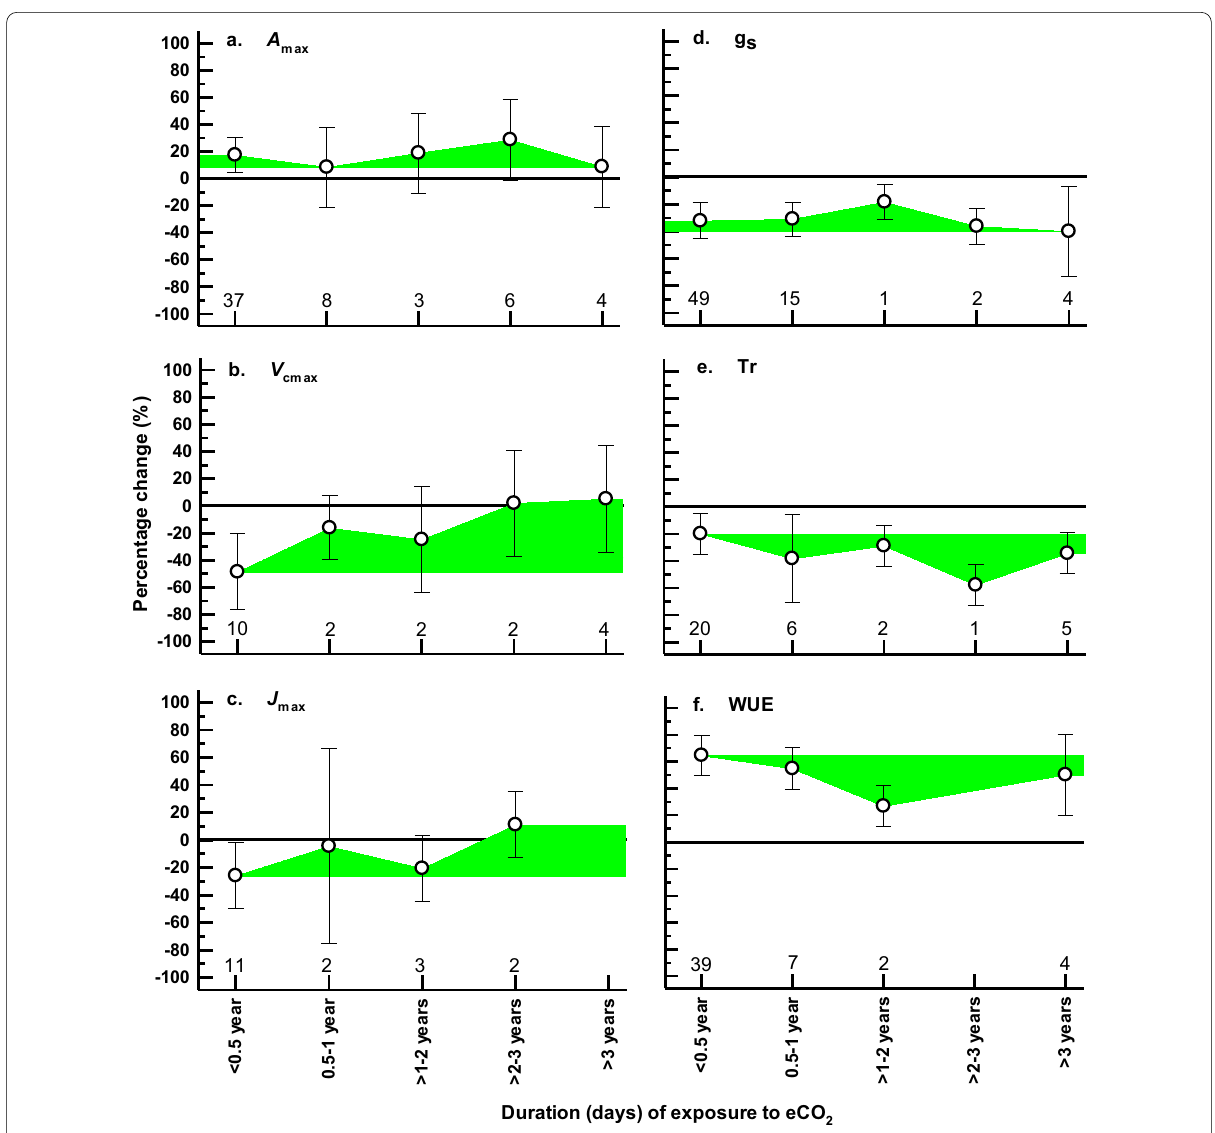
Fig. 5 Percentage change ( 95% CI) in photosynthetic characteristics ( a – c ), stomatal conductance ( d ) and water relations ( e – f ) of woody plants ± over different duration (years) of exposure to eCO 2 . The whiskers denote 95% CI and the circles denote mean percentage change (MPC) between aCO 2 and eCO 2 . The numbers above the major ticks of the x -axis denote number of observations. The area fill ( ) shows the trends and the magnitude of differences between duration of exposure to eCO 2 . The wider the area the bigger the difference between MPCs. Key to duration of exposure: 0.5 years denotes half of a year (6